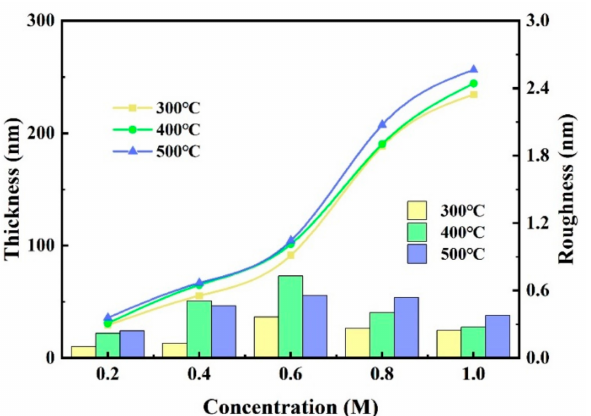
Figure 4. ZYAMO thin film thickness and roughness under different annealing temperatures and solution concentrations.